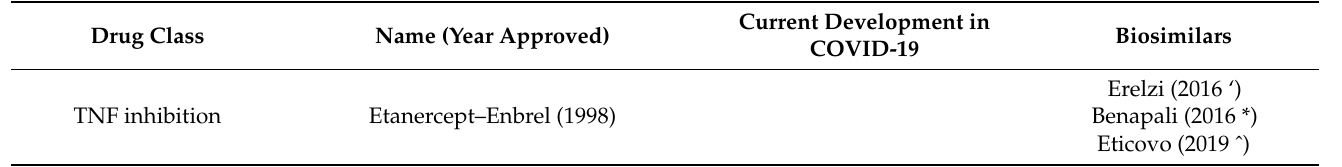
Table 1. Originator bDMARDs, their current development stage in COVID-19 and appropriate biosimilars. Drug